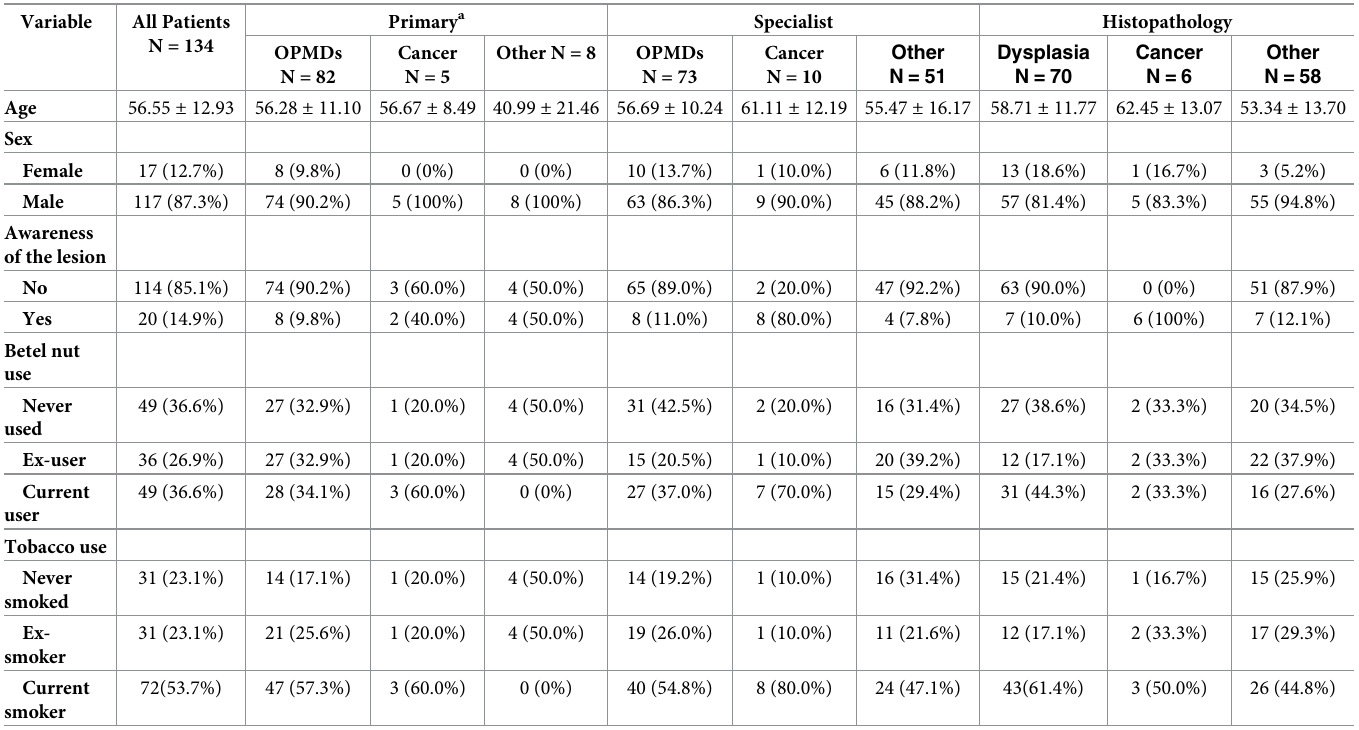
Table 1. Patient characteristics and histopathological diagnoses. Variable